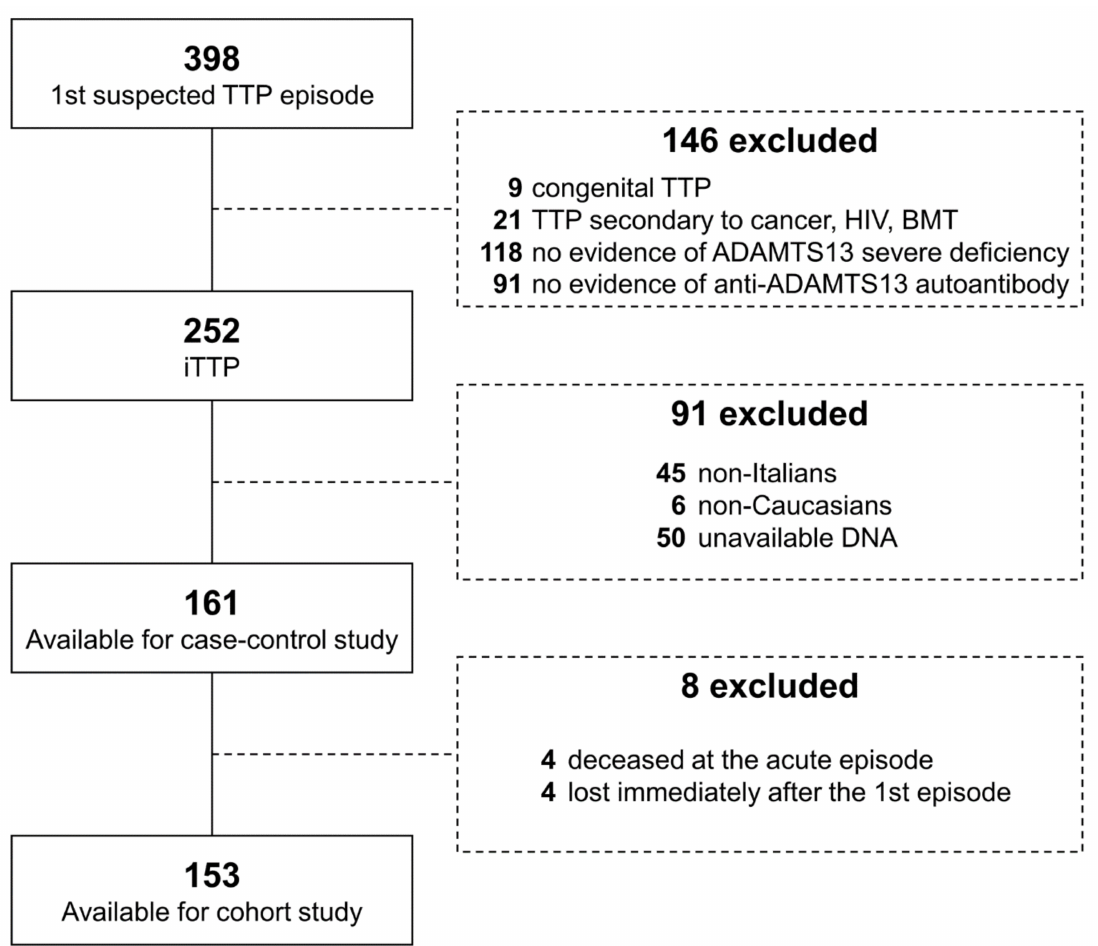
Figure 1. Study flow-chart. A patient could have been excluded as a result of more than one criterion. BMT, bone-marrow transplant; HIV, human immunodeficiency virus; iTTP, immune-mediated thrombotic thrombocytopenic